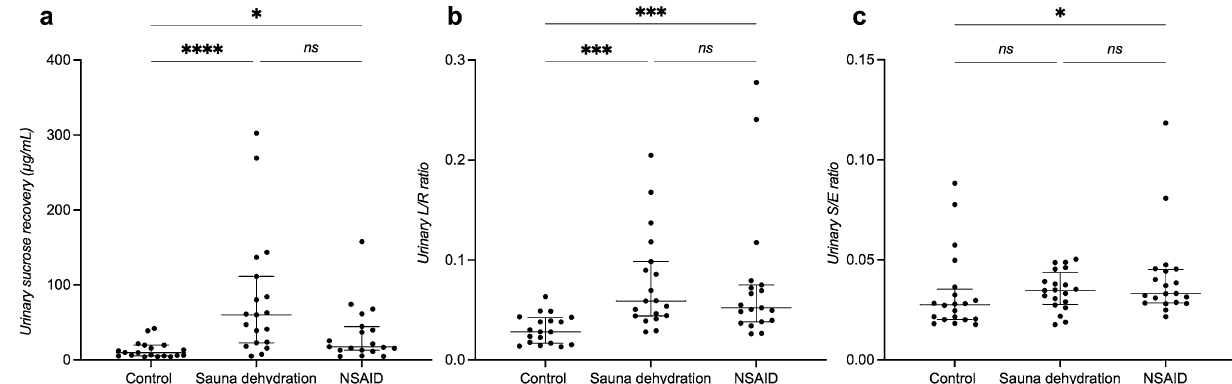
Figure 1. Intestinal permeability at the different test conditions. ( a ) Gastroduodenal permeability measured by urinary sucrose recovery (0-5 h). ( b ) Small intestinal permeability measured by lactulose/rhamnose (L/R) excretion ratio (0-5 h). ( c ) Colonic permeability measured by urinary sucralose/erythritol (S/E) excretion ratio (5-24 h). The horizontal line marks the median, the vertical line spans through the interquartile range (IQR). The dots represent the individuals.* P < 0.05. ** P < 0.01. *** P < 0.001. **** P < 0.0001. ns, non-significant. NSAID, nonsteroidal anti-inflammatory drug.